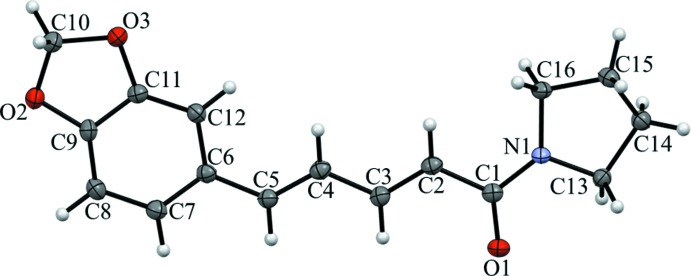
Displacement ellipsoid drawing at a 50% probability level of the asymmetric unit of (II).